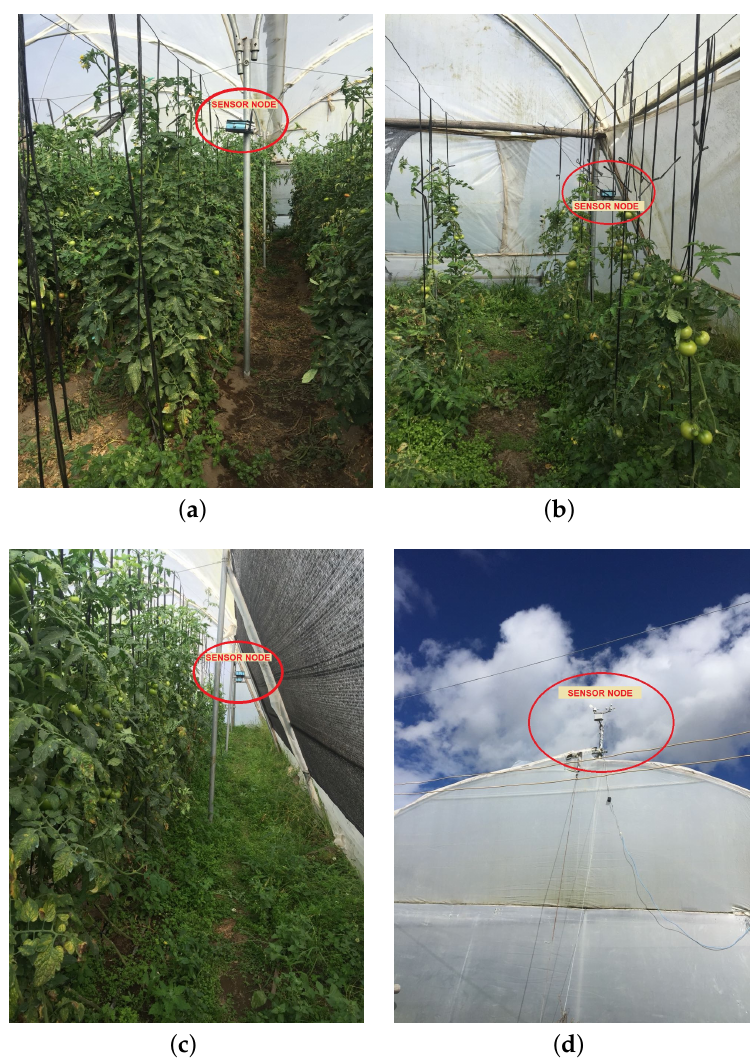
Figure 8. WSNs test scenario. ( a ) Node 4 of WiFi network; ( b ) Node 2 of WiFi network; ( c ) Node 1 of DigiMesh network; ( d ) Node 1 of ZigBee